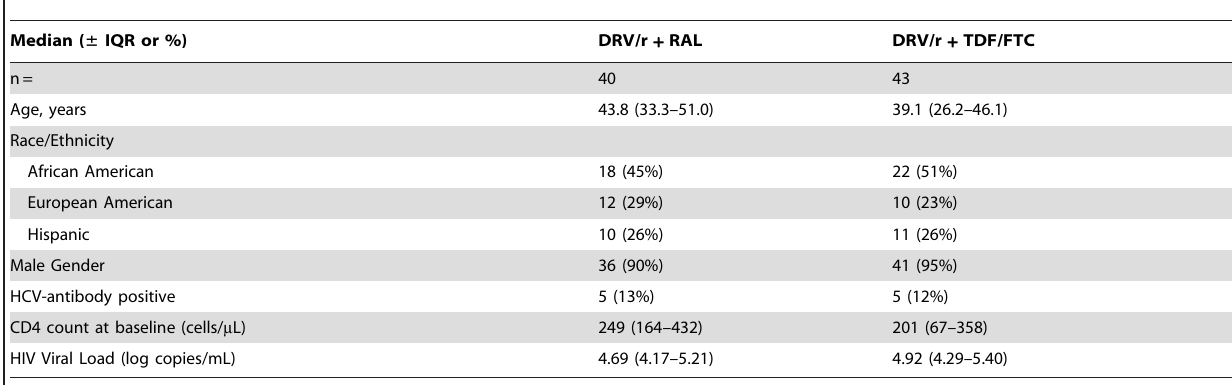
Table 1. Demographics and Baseline Characteristics .